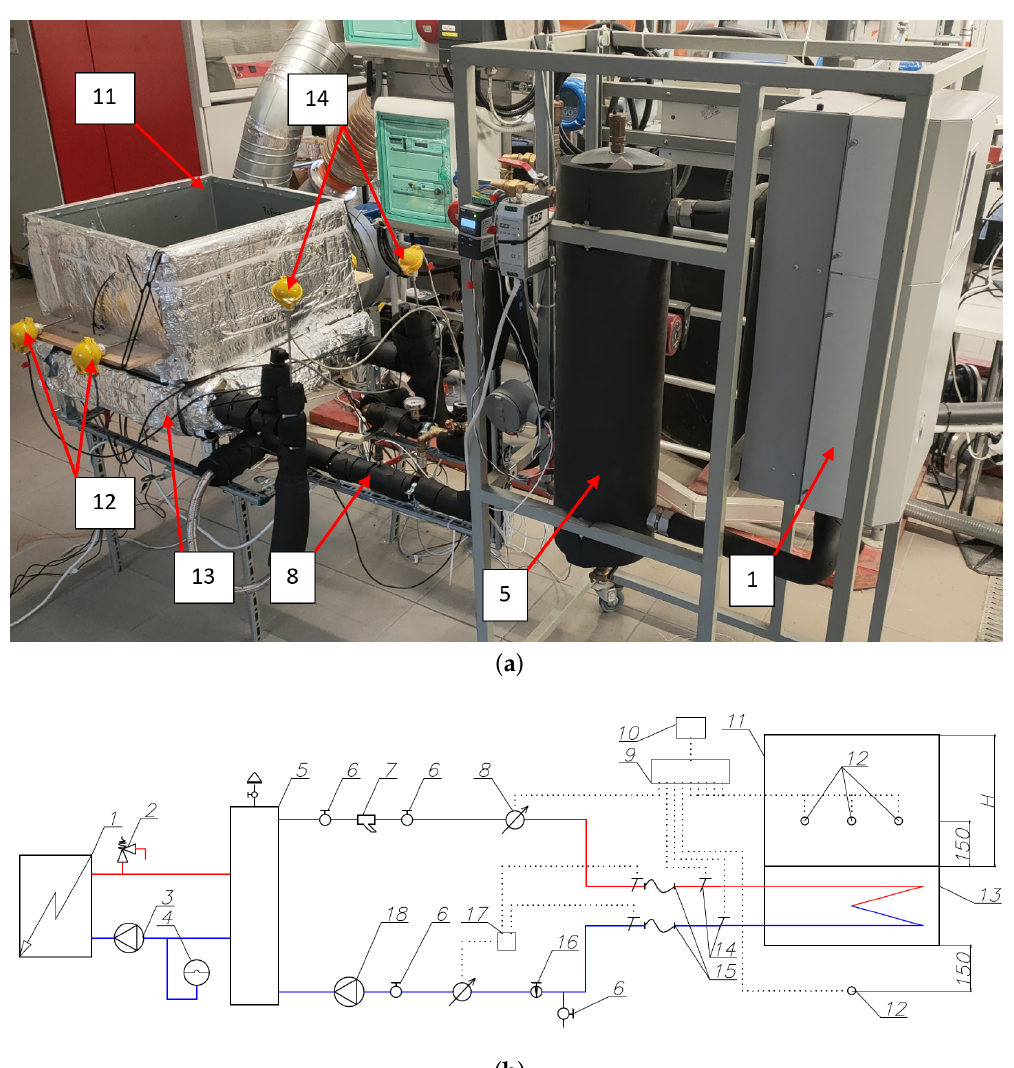
Figure 1. Experimental apparatus: 1—electric boiler; 2—safety valve; 3—boiler circuit pump; 4—expansion vessel; 5—low loss header; 6—ball valve; 7—slanted filters;